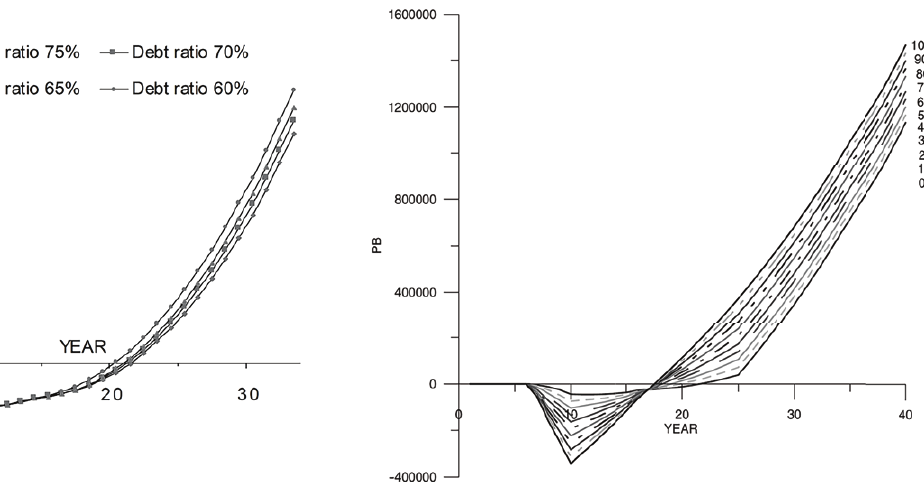
Figure 6. Comparison of accumulated discounted cash flow with reference